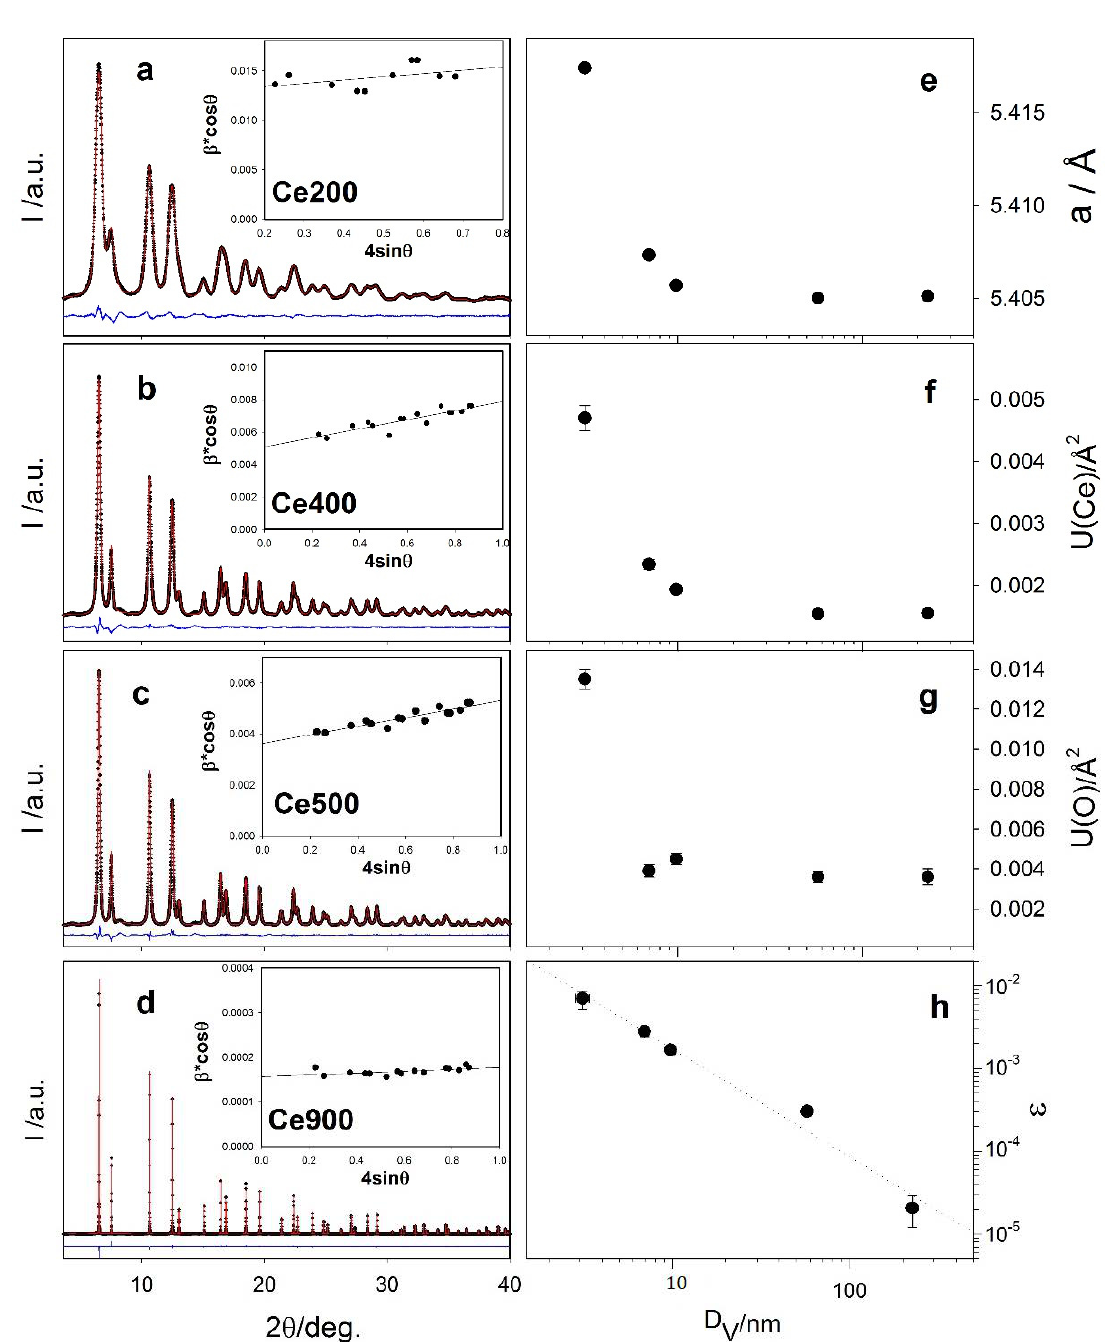
Figure 1. Experimental XRPD patterns (black dots), best fits of Rietveld analysis (red curves) and residuals (blue curves) collected on samples Ce200, Ce400, Ce500 and Ce900 (panels ( a – d )). The WH analysis of the same patterns is included in the insets. Selected refined parameters of the Rietveld refinements are reported in panels ( e ) (cell parameter) and ( f , g ) (Ce and O displacement parameters) as a function of the crystallite dimension D V . Panel ( h ) shows the trend of strain versus D V according to WH analysis results. Table 1. Outcomes of Rietveld refinements and WH analysis as a function of the annealing temperature.